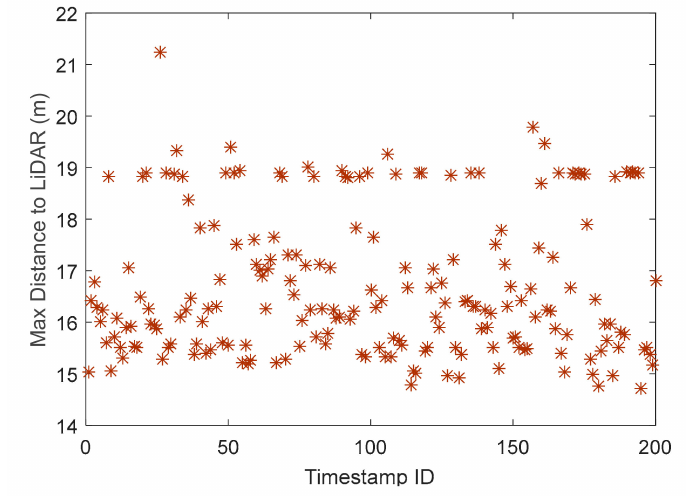
Figure 7. Maximum distance distribution of the snowflakes to the